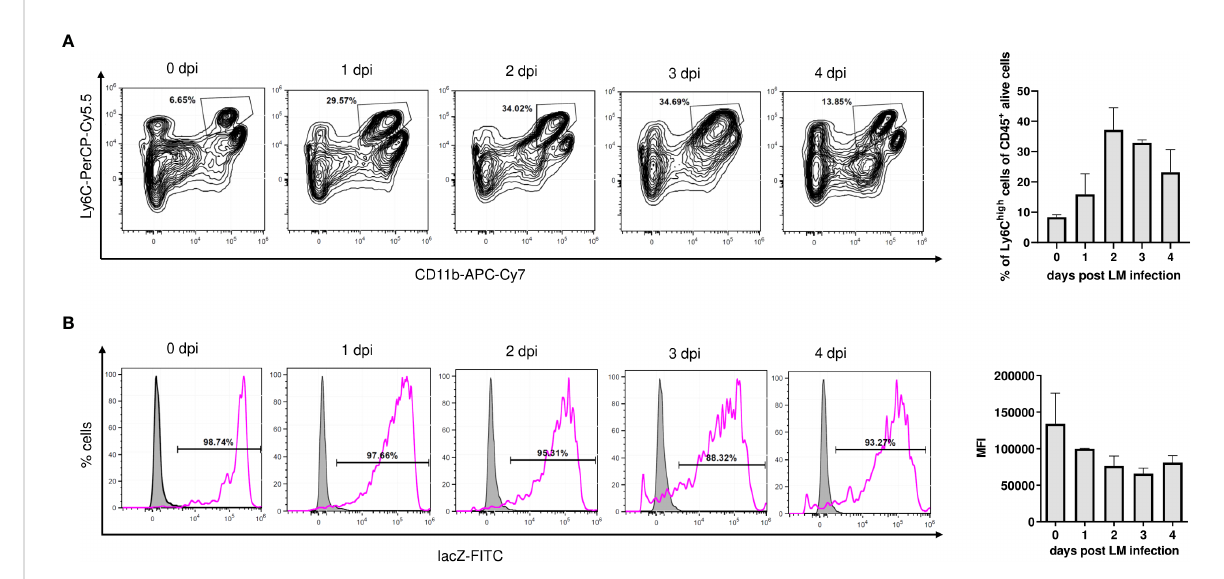
FIGURE 3 Nfkbid promoter activity in Ly6C high monocytes of Nfkbidlacz reporter mice during Lm infection. Nfkbid lacZ reporter mice (n = 4-5 mice per time point) were infected with LM (3 x 10 4 CFU/mouse) and sacri fi ced on indicated time points. Livers were sampled, total leukocytes were isolated and analyzed by FACS in combination with lacZ FDG reporter assay. CD11b + Ly6 high in fl ammatory monocytes in the liver were pre-gated on viable singlet CD45 + cells and Nfkbid promoter activity was determined as median fl uorescence intensity of fl uorescein reporter dye. (A) Representative contour plots, showing gating and frequency of CD11b + Ly6 high in fl ammatory monocytes (left) and summarized frequency data representing mean ± SD (right). (B) Representative histograms of lacZ reporter fl uorescence intensity in gated CD11b + Ly6C high in fl ammatory monocytes (pink) and reporter negative control (grey). Summarized Nfkbid lacZ reporter intensity representing mean ± SD is shown on the right. Shown data are from one out of two independent experiments with similar